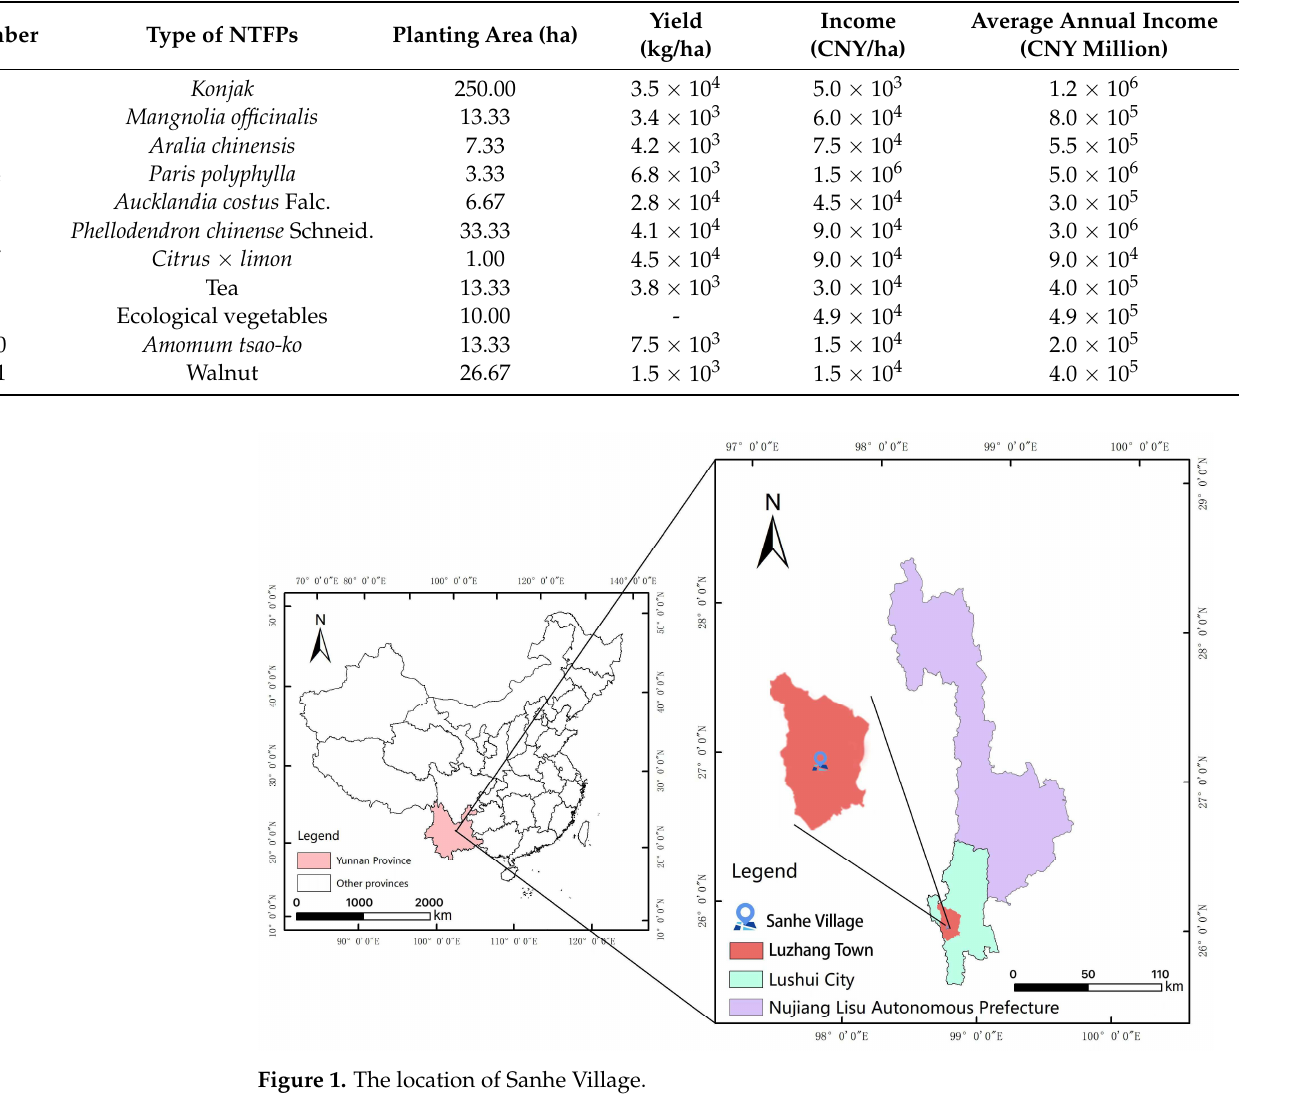
Figure 1. The location of Sanhe Village. Table 1. The planting areas of and income from the NTFPs industry in Sanhe Village.